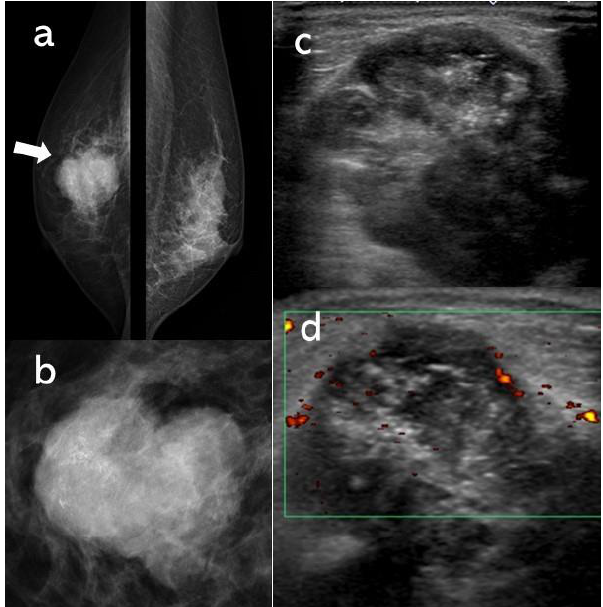
Figure 1. Bilateral mediolateral oblique ( a : arrow) and right craniocaudal spot compression ( b ) mammograms demonstrate a 40-mm lobulated mass with relatively smooth borders containing coarse calcification. Ultrasound B-mode imaging ( c ) reveals a hypoechoic 40-mm lobulated right breast mass with relatively smooth borders containing a punctate-to-coarse hyperechoic area that corresponds to the calcification and the power Doppler imaging ( d ) showing blood flow mainly in the peripheral area of the tumor.